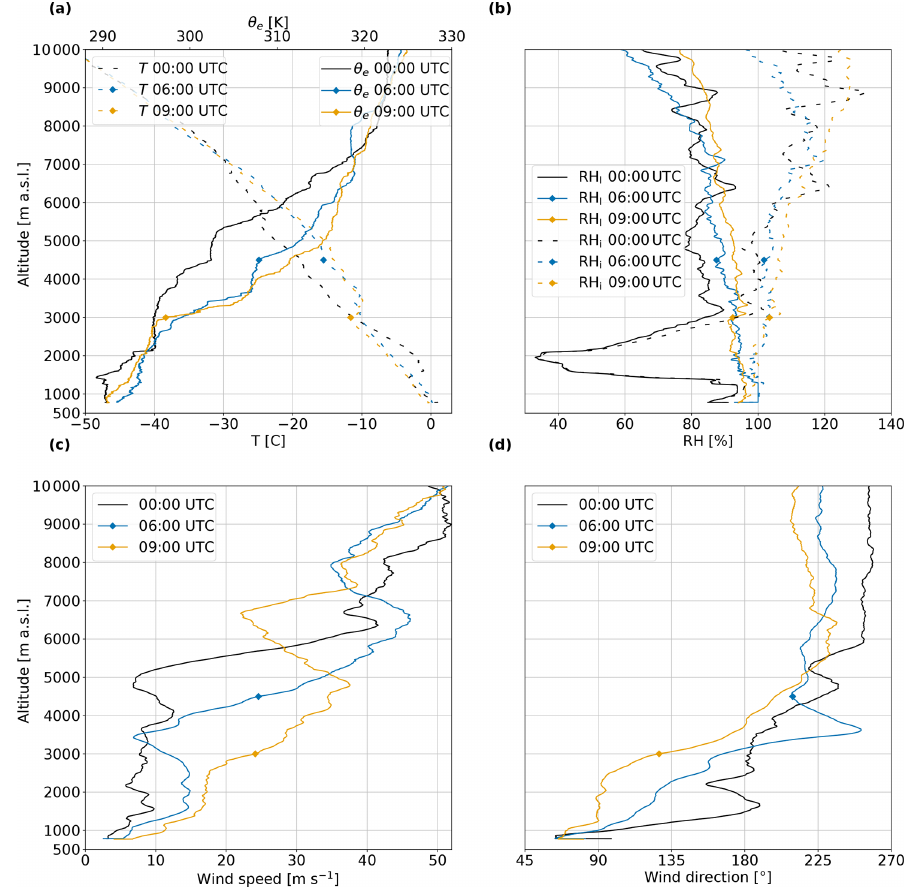
Figure 6. Radiosoundings at the DGW station showing (a) temperature (dashed lines) and equivalent potential temperature (solid lines); (b) relative humidity with respect to liquid (RH l ; solid lines) and ice (RH i ; dashed lines); (c) wind speed; and (d) wind direction at 00:00UTC (black), 06:00UTC (blue) and 09:00UTC (yellow) on 28 February 2018. The diamond symbols for the radiosoundings at 06:00 and 09:00UTC show the altitude of the lower limit of the WCB (black contour in Fig. 5a, b,